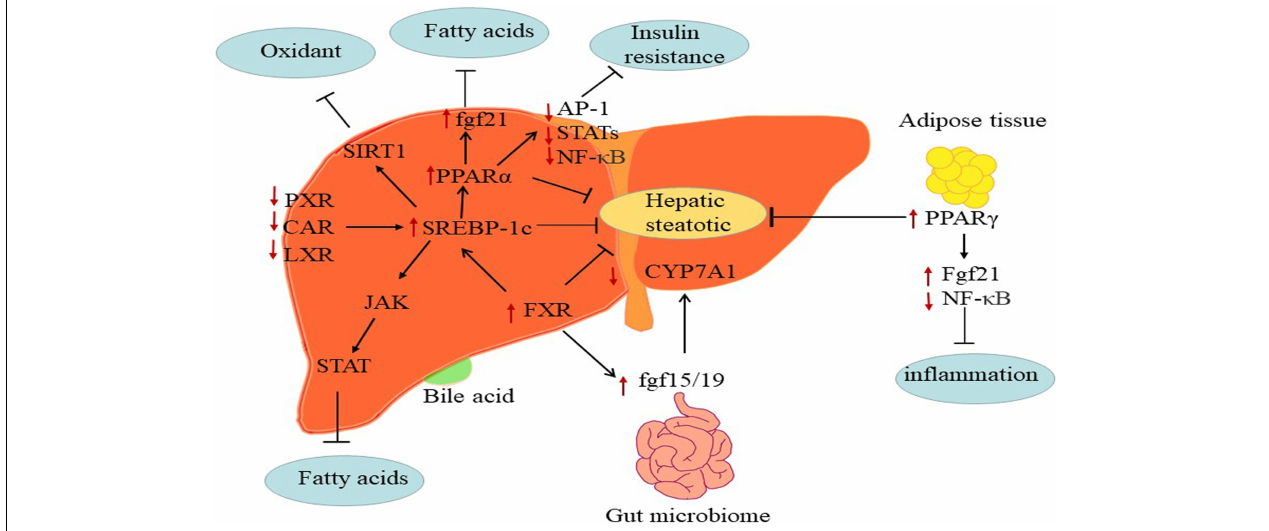
FIGURE 3 | The mechanisms of major metabolic targets regulating the progression of NAFLD. PPARs: The FGF21 directly targeting PPARs key pathogenesis of NASH are hepatic free fatty acids. And activated PPAR α may negatively interfere with the activity of pro-inflammatory transcription factors AP-1, STATs, and NF- κ B. PPAR γ attenuates inflammation via inhibiting NF- κ B activity and elevating FGF21 in adipose tissue. FXR: FXR regulates hepatic bile salt synthesis through stimulating FGF15 (FGF19 in humans) expression in the intestinal and repressing CYP7A1 in the liver. LXR: Inhibition of LXR α via SREBP-1c contributes to alleviate progress of hepatic steatosis. PXR and CAR: PXR and CAR regulates SREBP1 involved in metabolic